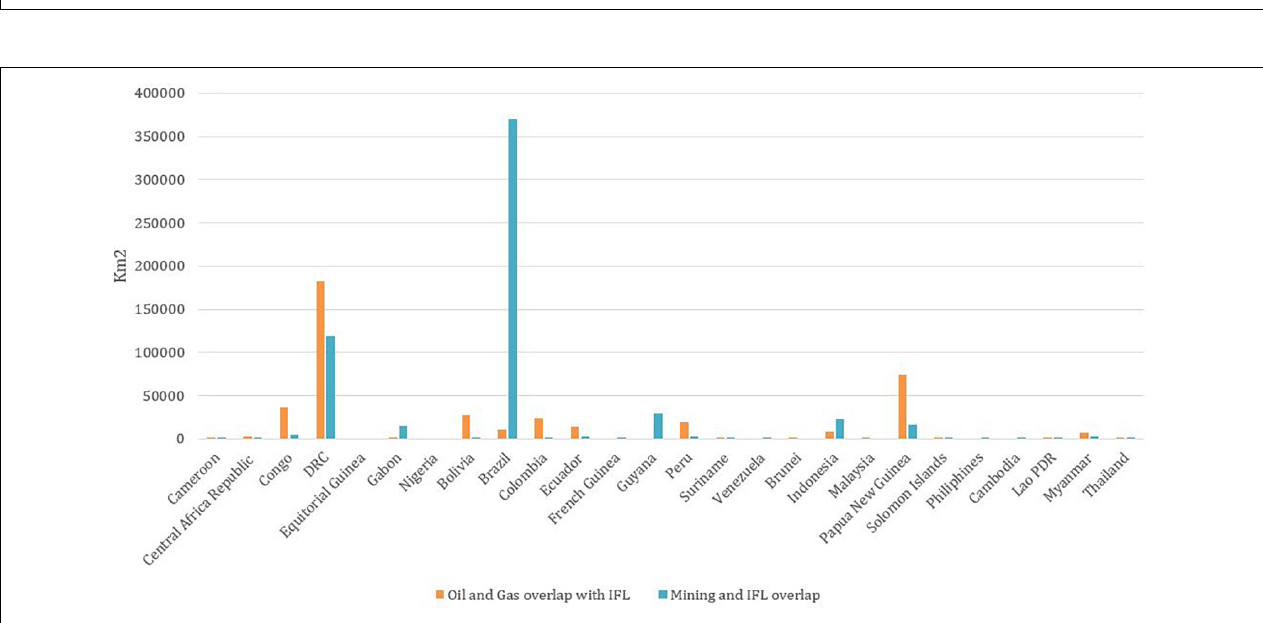
FIGURE 2 | The area of overlap of Oil and Gas contracts, and mining claims and IFLs within each country in the study region.